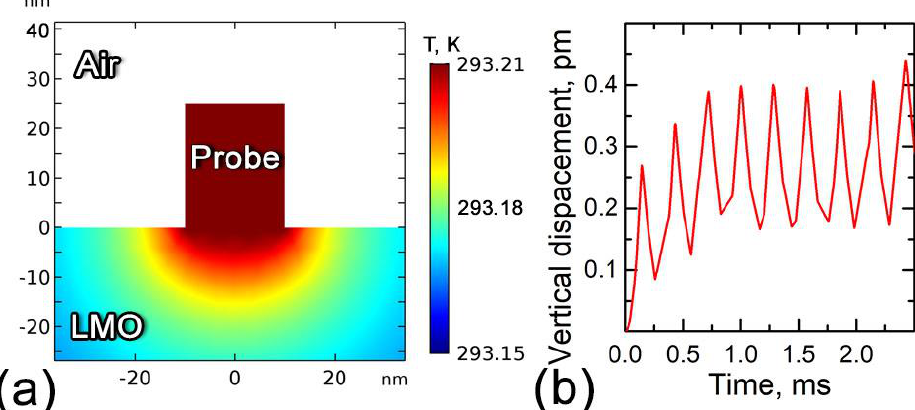
Figure A3. Finite element modeling of the local heating in a LiMn 2 O 4 particle under the action of a 5 kHz 10 V AC voltage applied to the probe tip: ( a ) Distribution of temperature. ( b ) Temporal dependence of the electro-mechanical displacement induced by the local heating under the action of the electric current flow.